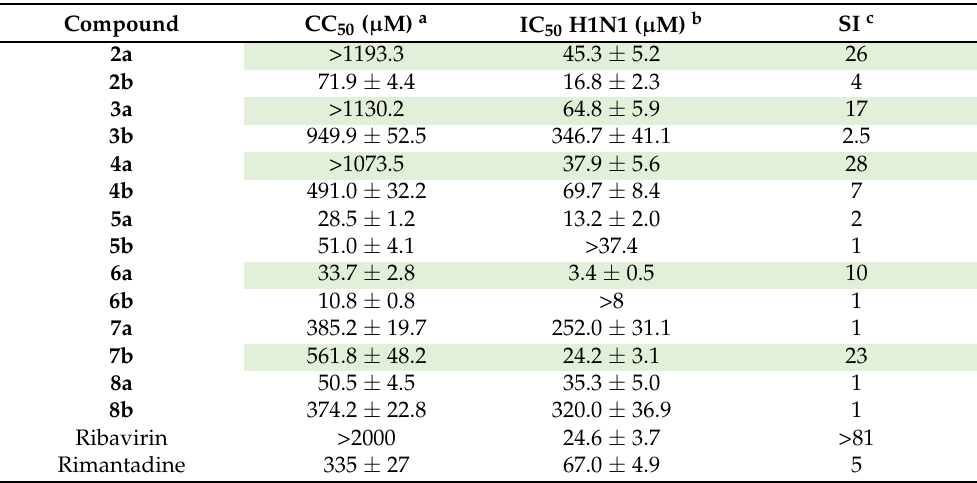
Table 1. Antiviral activity of the compounds 2–8 a–b against influenza virus A/Puerto Rico/8/34 (H1N1) in MDCK